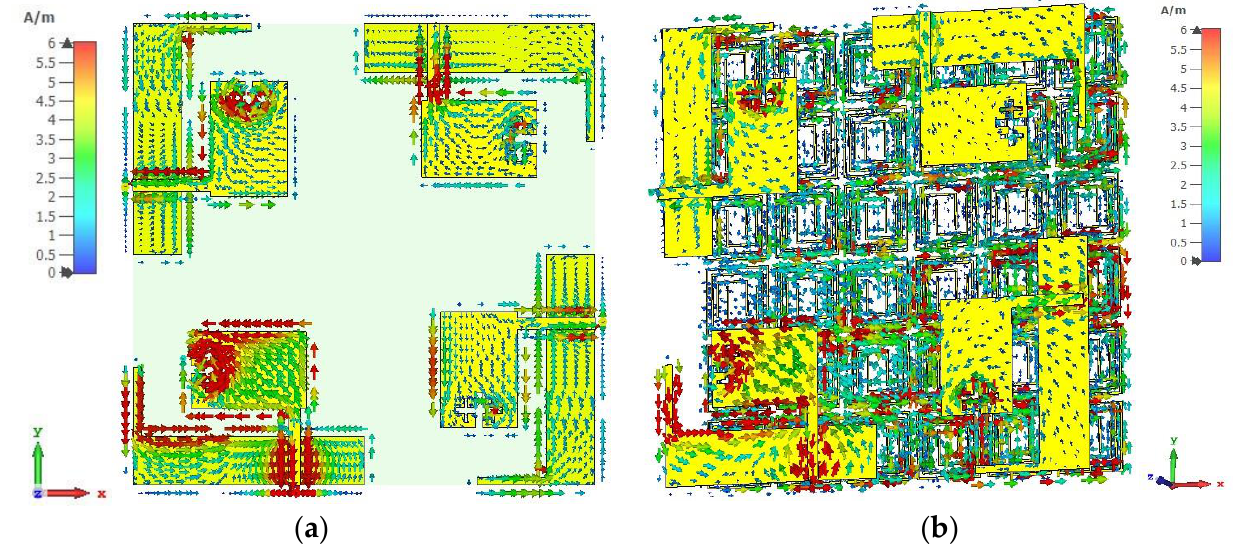
Figure 9. Current distributions at 4.5 GHz for proposed 4-port MIMO antenna ( a ) MIMO without MM and ( b ) MM-based MIMO.